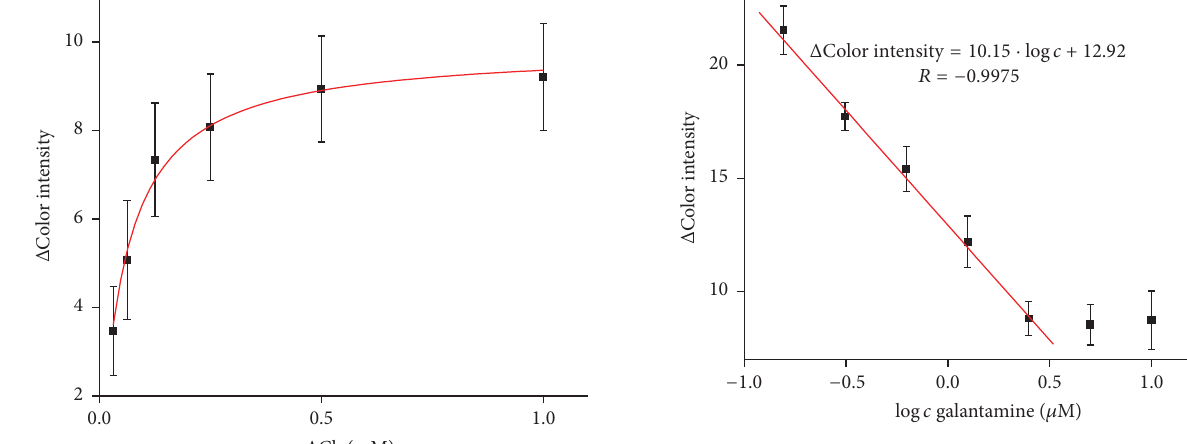
Figure 6: Calibration curve of galanthamine; concentration is given in logarithm. Error bars represent standard error of the mean for 𝑛 = 3.